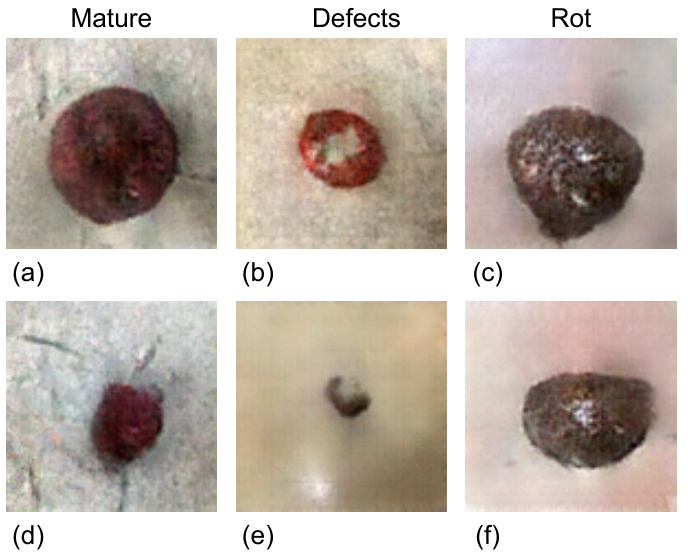
Figure 7. Samples generated by GAN. ( a – c ) are three generate samples with good quality, and ( d – f ) are three generated ones with poor